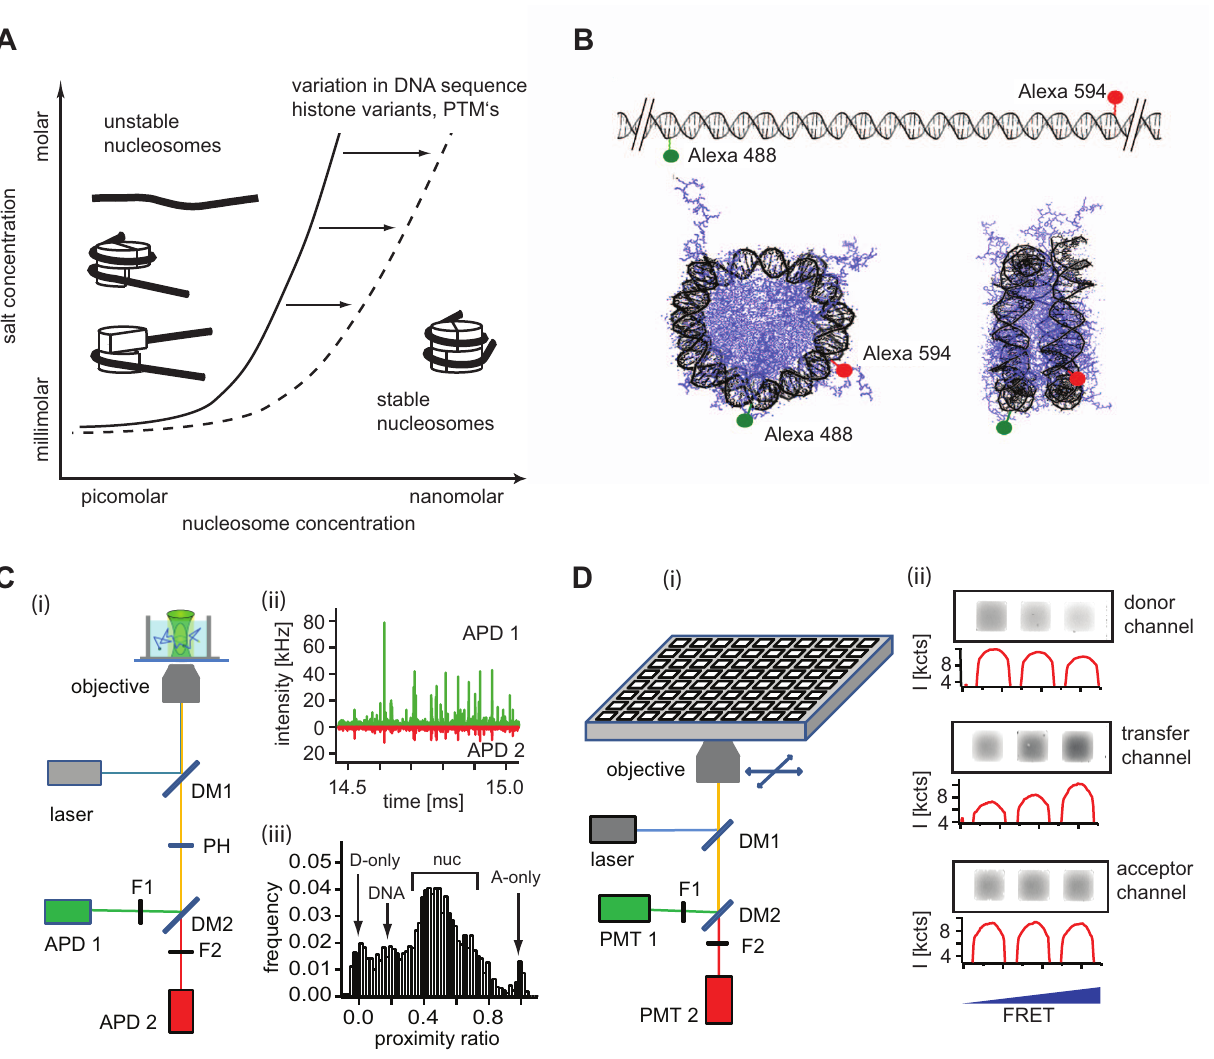
Figure 1. A combined single molecule – bulk FRET approach to study nucleosome stability. A ) Theoretical diagram of nucleosome stability as a function of salt and nucleosome concentration (adapted from ref. [22]). The solid line represents the amount of salt needed to destabilize nucleosomes at a given nucleosome concentration. Nucleosomes generally remain stable at higher concentrations and lower ionic strength, dissociation occurs at elevated ionic strength and nucleosome concentrations in the sub-nM range. The dashed line represents changes in nucleosome stability from altered nucleosome composition. B) DNA labeling for nucleosome FRET experiments. 170 bp long DNA fragments were labeled at positions -42 and + 52 from the dyad axis. In the intact nucleosome both dyes are located < 6 nm apart, allowing for FRET, while in a fully dissociated nucleosome or free DNA fragment both dyes are too far apart to undergo FRET. C ) (i) Schematic of confocal single molecule detection of nucleosomes in solution. A detailed description of the setup is given in Section S1 in File S1. (ii) The passage of individual nucleosomes through the focus generates bursts of fluorescence. (iii) For each burst a proximity ratio is calculated and data binned for histogram analysis. The position of relevant subpopulations in the histogram is indicated. D ) (i) Schematic setup for microplate-scanning FRET ( m psFRET). Samples are loaded into a 384- well multiplate and imaged in three spectral channels using a commercial Typhoon TM multimode scanner with confocal optics (i). Grey scale images and intensity profiles of samples with different bulk FRET efficiencies (ii). Higher FRET leads to a decrease of signal in the donor channel and a corresponding increase of signal in the transfer channel. The signal in the acceptor channel remains unaffected. From these intensities P-values are calculated for each well. Abbreviations: DM: dichroic mirror, F: emission filter, APD: avalanche photodiode, PMT, photomultiplier tube, PH: